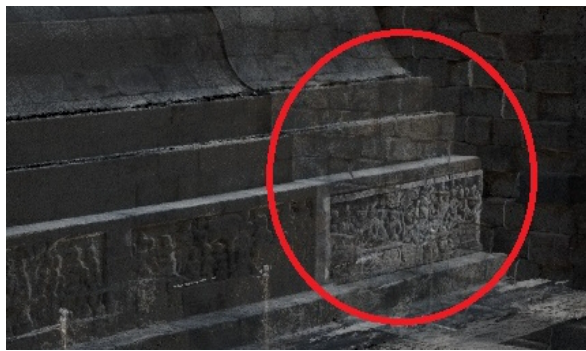
Figure 10. Fused transparent visualization result (zoomed in).